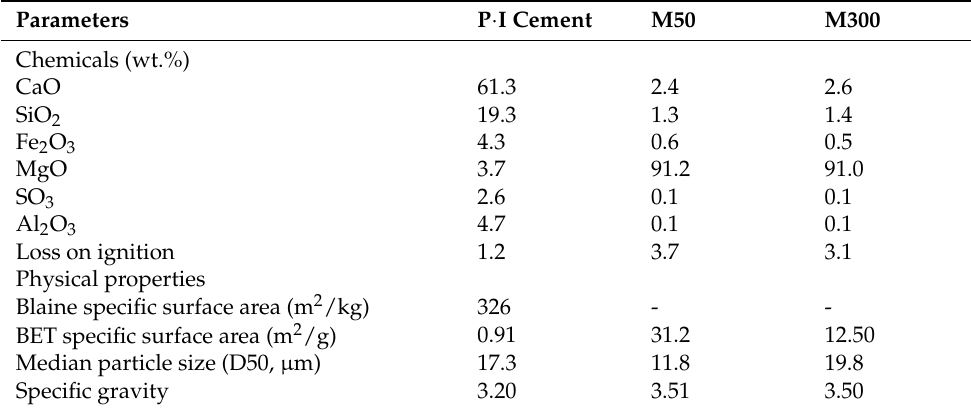
Table 1. Physical properties and chemical compositions of P · I cement and